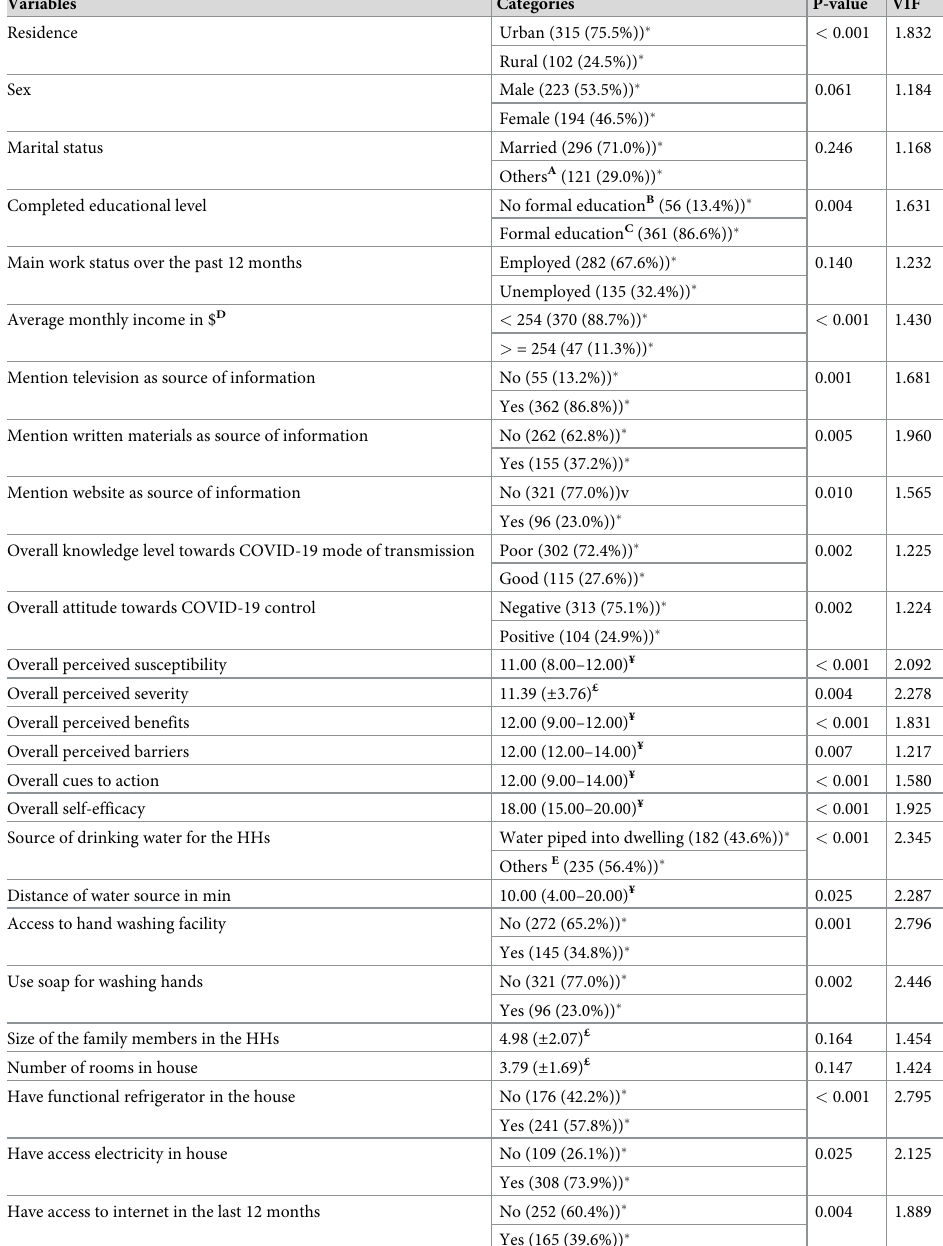
Table 4. Bivariate proportional odds model and multicollinearity diagnosis results (n =